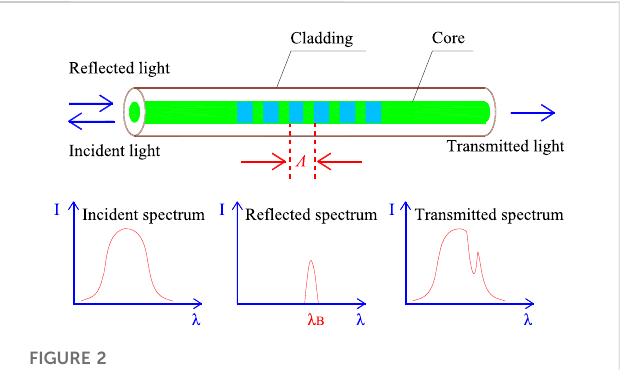
FIGURE 2 Structure and sensing characteristics of fi ber Bragg